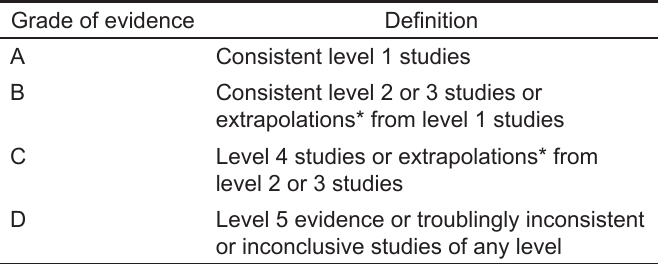
Table 2. Oxford Centre for Evidence-Based Medicine grades of recommendation.